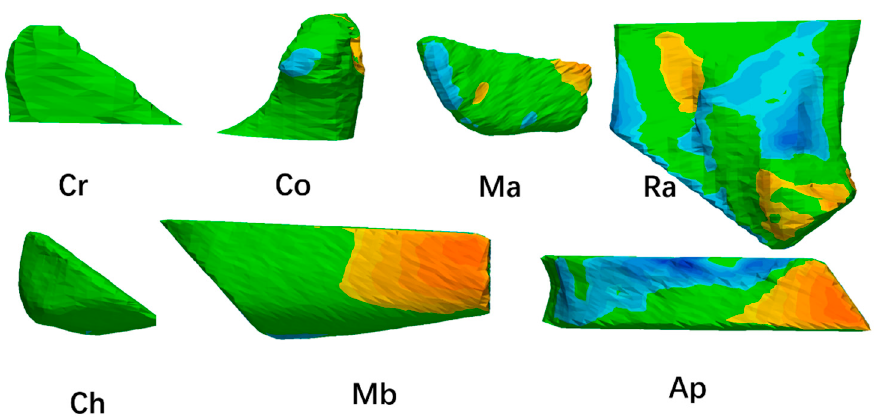
Figure 6. Surface deviation analysis of the mandibular units. The map showed the difference be- tween the original model and the mirrored 3D models. The colored maps showed the negative (blue) and positive (yellow and red) deviation values. The ranges of tolerance at 0.5 mm are shown in green.